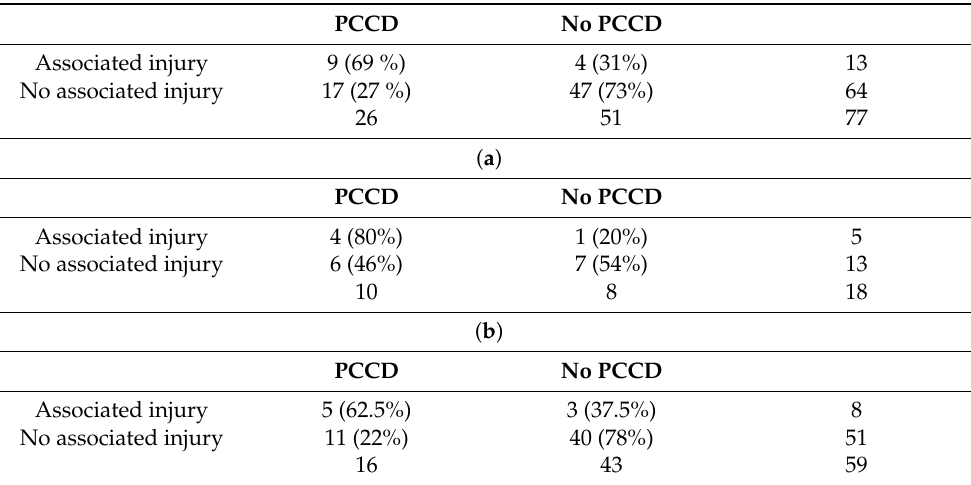
Table 6. Contingency table of all documented associated injuries in relation to applied PCCD. ( a ) Contingency table of all documented associated injuries in patients with unstable fractures in relation to applied PCCD. ( b ) Contingency table of all documented associated injuries in patients with stable fractures in relation to applied